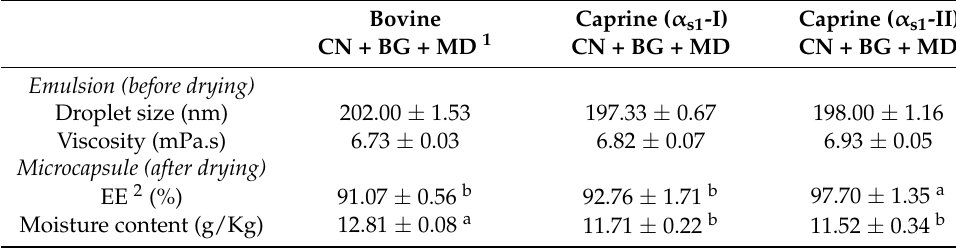
Table 2. Physicochemical properties of lutein-loaded emulsions and lutein